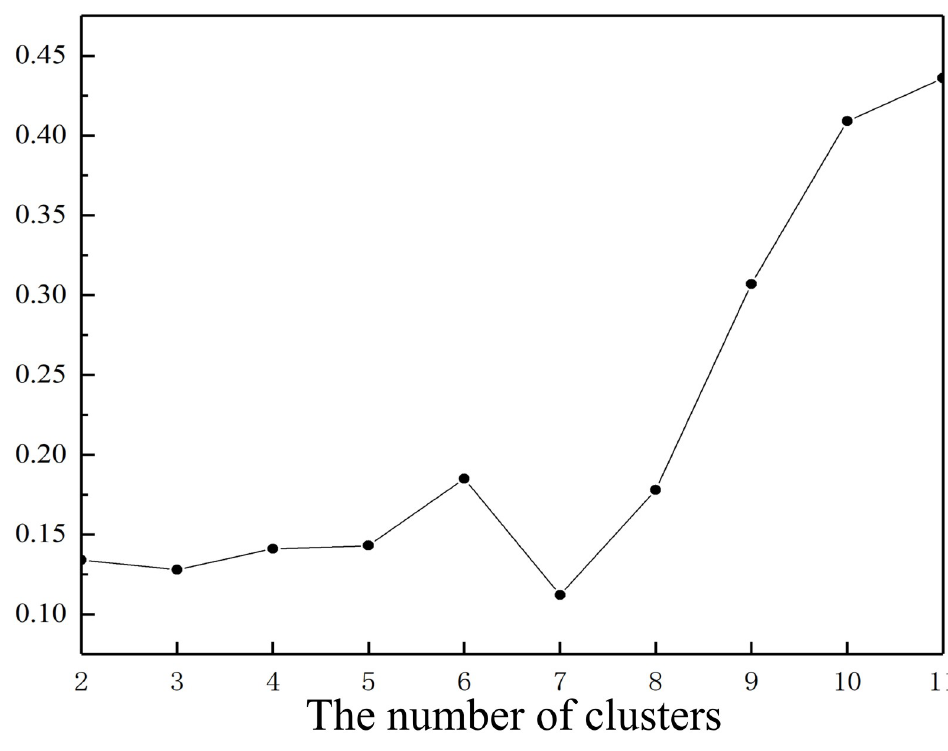
Fig 6. V xie of different clusters.